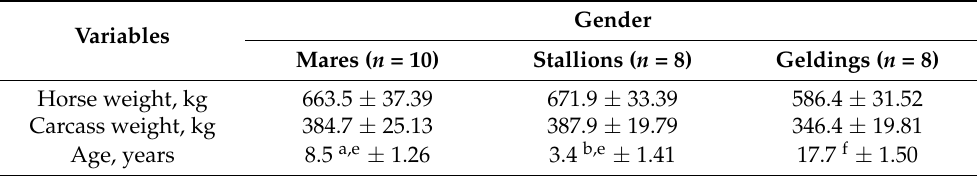
Table 1. Characteristics of slaughtered